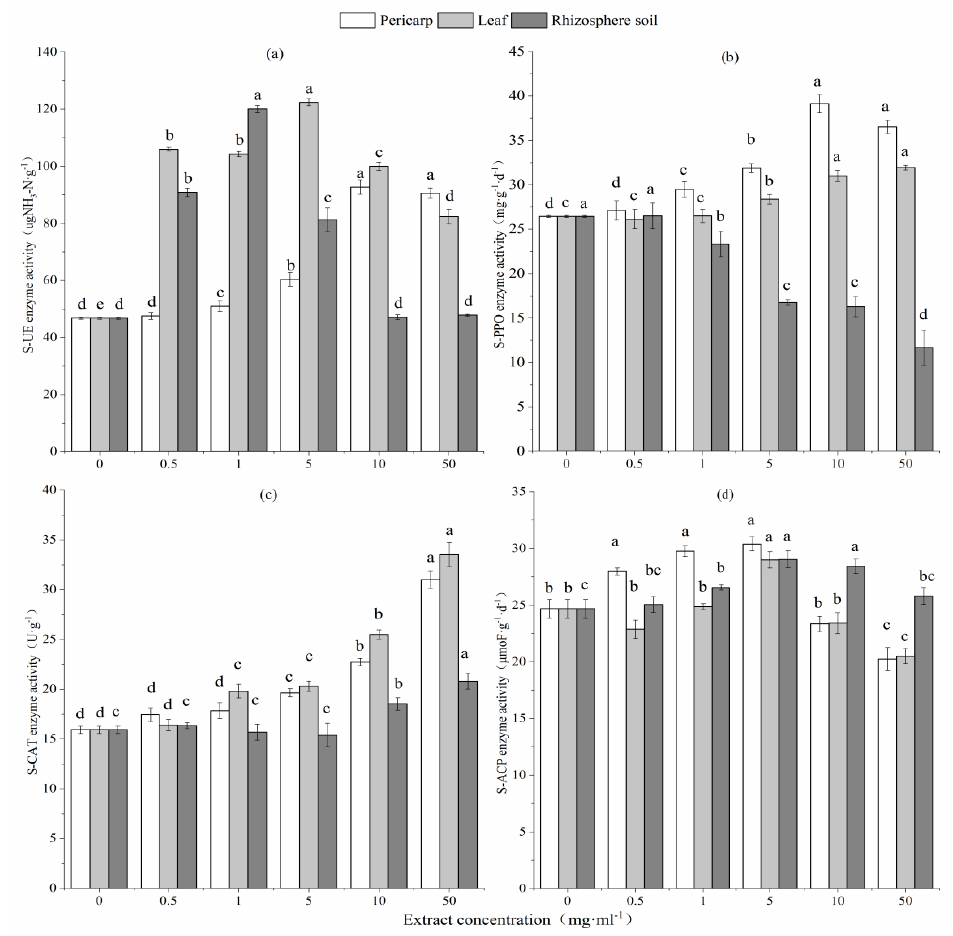
Figure 5. Activities of soil urease (S-UE) ( a ), polyphenol oxidase (S-PPO) ( b ), catalase (S-CAT) ( c ), and phosphatase (S-ACP) ( d ) in L. formosana seedlings following treatment with di ff erent concentrations of C. migao pericarp, leaf, and rhizosphere soil aqueous extracts. Lowercase letters represent significant di ff erences in each treatment group ( p < 0.05).